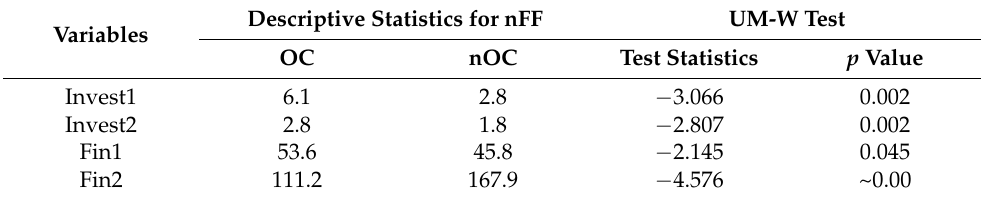
Table 6. Descriptive statistics describing investment and financing strategy and firm in subsamples for non-family